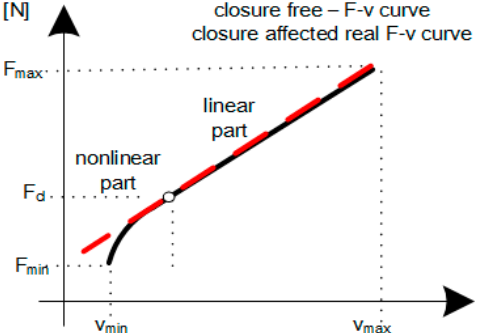
Figure 5. Fatigue crack growth rate (FCGR) test measurement stand (1—MTS load cell, 2—MTS clevis for fracture mechanics, 3—MTS clip gage—extensometer, 4—MTS remote control panel, 5— specimen) .